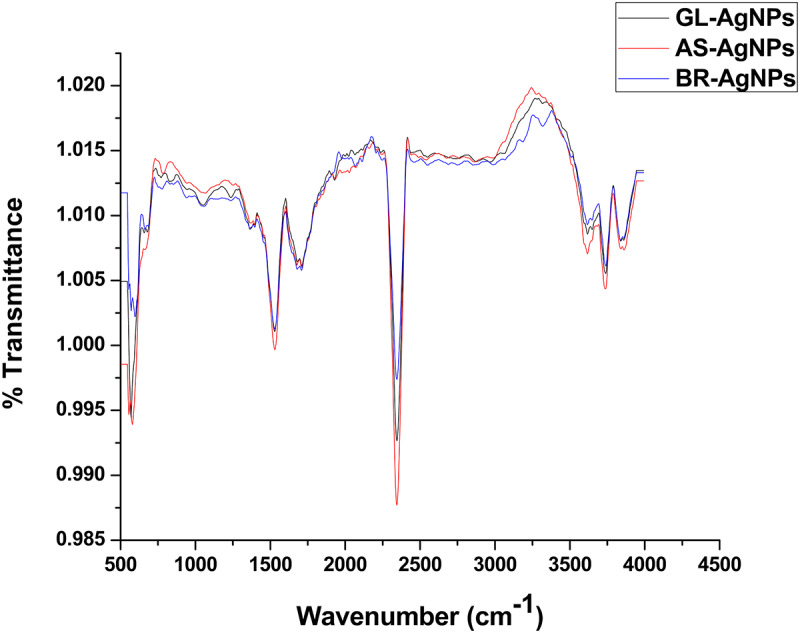
ATR-FTIR analysis of AgNPs.